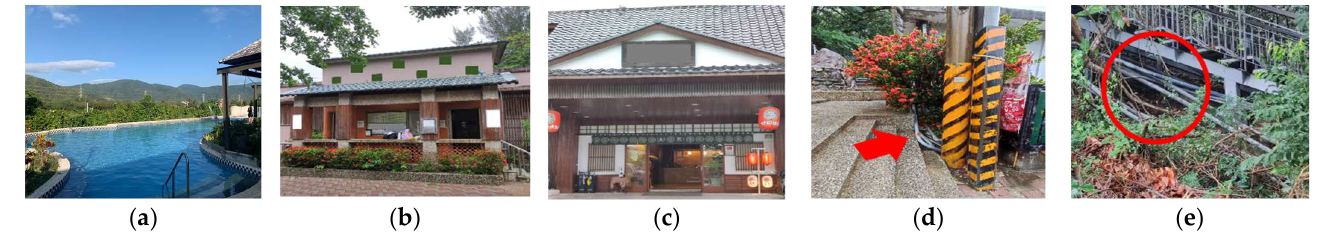
Figure 3. The Sichongxi Hot Springs area, which has many hotels, B&Bs, and resorts. Students visited this area for the purpose of understanding health tourism during COVID-19. ( a ) The resort of hot springs has a pool with a nice view for relaxing between water and mountains; ( b ) The public hot spring is free of charge for local residents and tourists, and was built in 1985; ( c ) The hot spring with a Japanese style, was built in 1930 for Japanese occupations; ( d ) The hot-spring pipeline behind the aisle; ( e ) The pipeline has evidenced a complicated problem of water (hot springs), groundwater, land, and the management of the pipeline, B&Bs, hotels, and resorts.